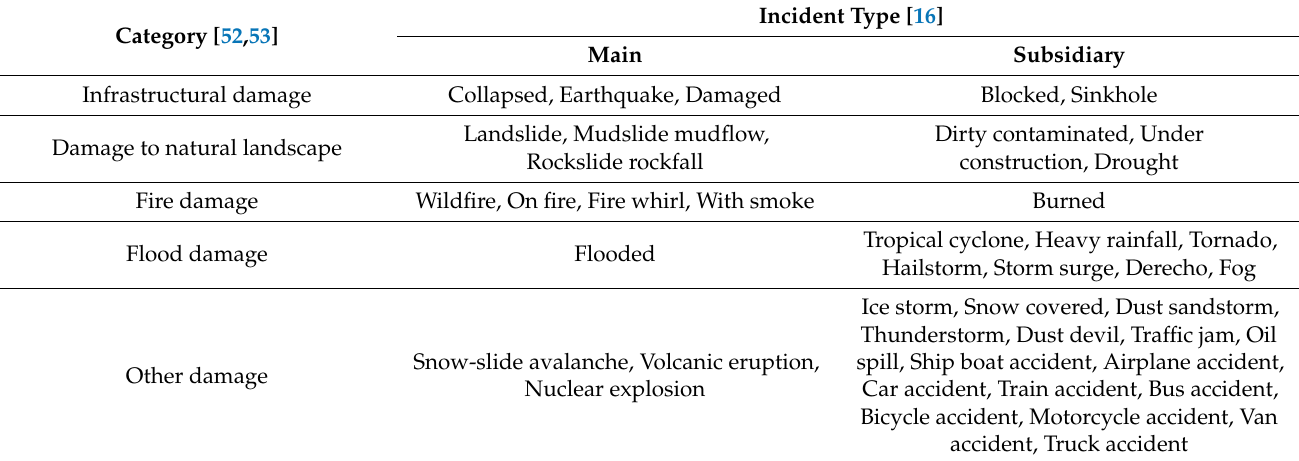
Table 1. Re-categorization of incident